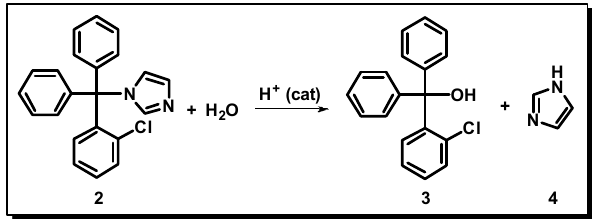
Figure 10. Reaction scheme showing the degradation of clotrimazole in acid medium.